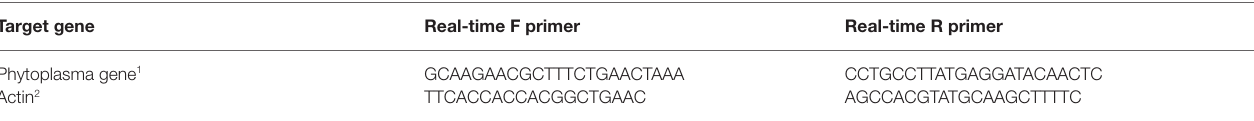
TABLE 2 | Target and endogenous control genes used for real-time qPCR and primer sequences indicating the presence of a phytoplasma causing cranberry false blossom disease in cranberry leaves. Target